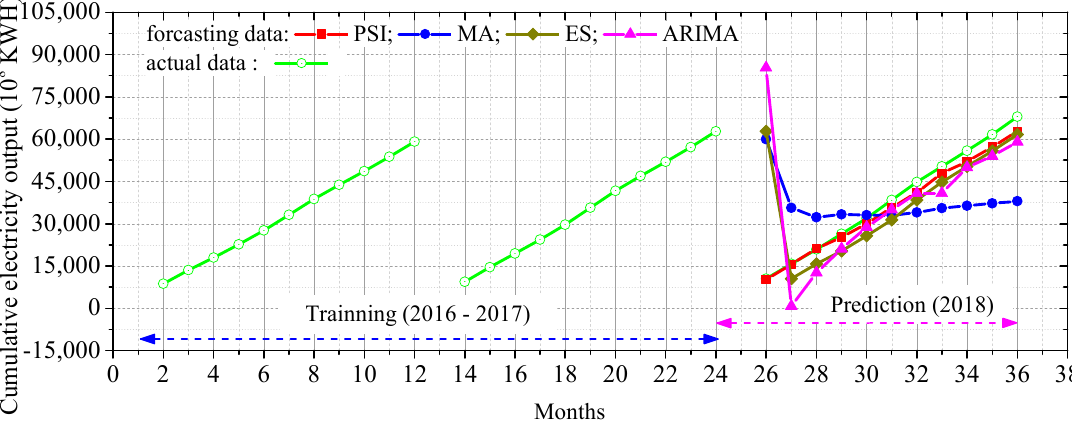
Figure 6. Time series pattern and prediction on cumulative electricity output (CEO) dataset.